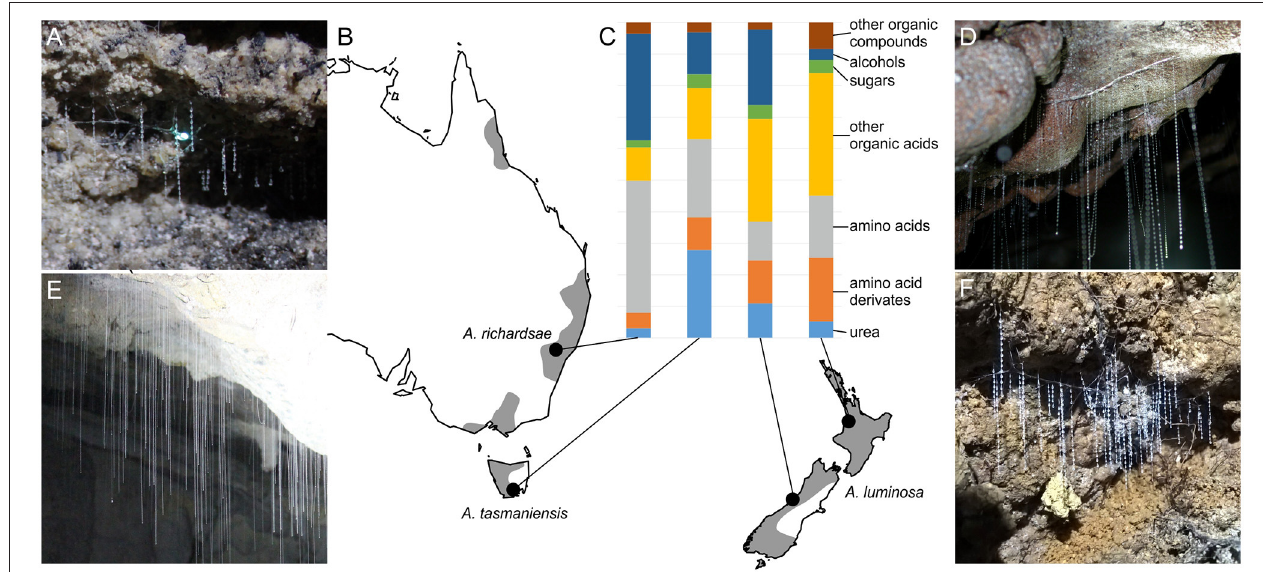
FIGURE 1 | Arachnocampa species and composition of their prey capture adhesive. (A,D,E,F) Morphology of snares of sampled glowworm species. (A) A. richardsae . (D) A. luminosa , North Island. (E) A. tasmaniensis . (F) A. luminosa , South Island. (B) Map with gray shade indicating the known distribution range of the genus (modified from records in the Atlas of Living Australia, https://www.ala.org.au/), map created using the R package maps (Brownrigg, 2013). (C) Bar plot showing the relative abundance of compounds identified in the glowworm adhesive wash with NMR. Note that compounds with unspecific identity, such as fatty acids, or that are not captured by solution state NMR (e.g., peptides) are not shown